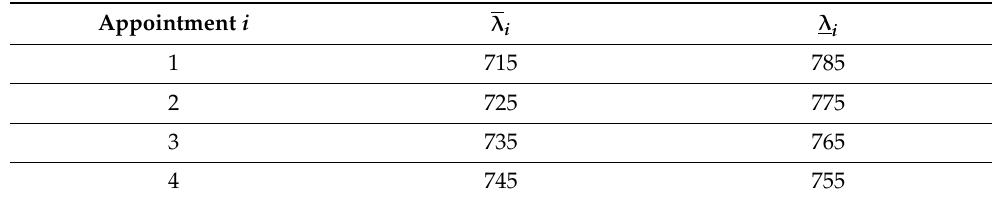
Table 2. Lower and upper bounds on the uncertainty